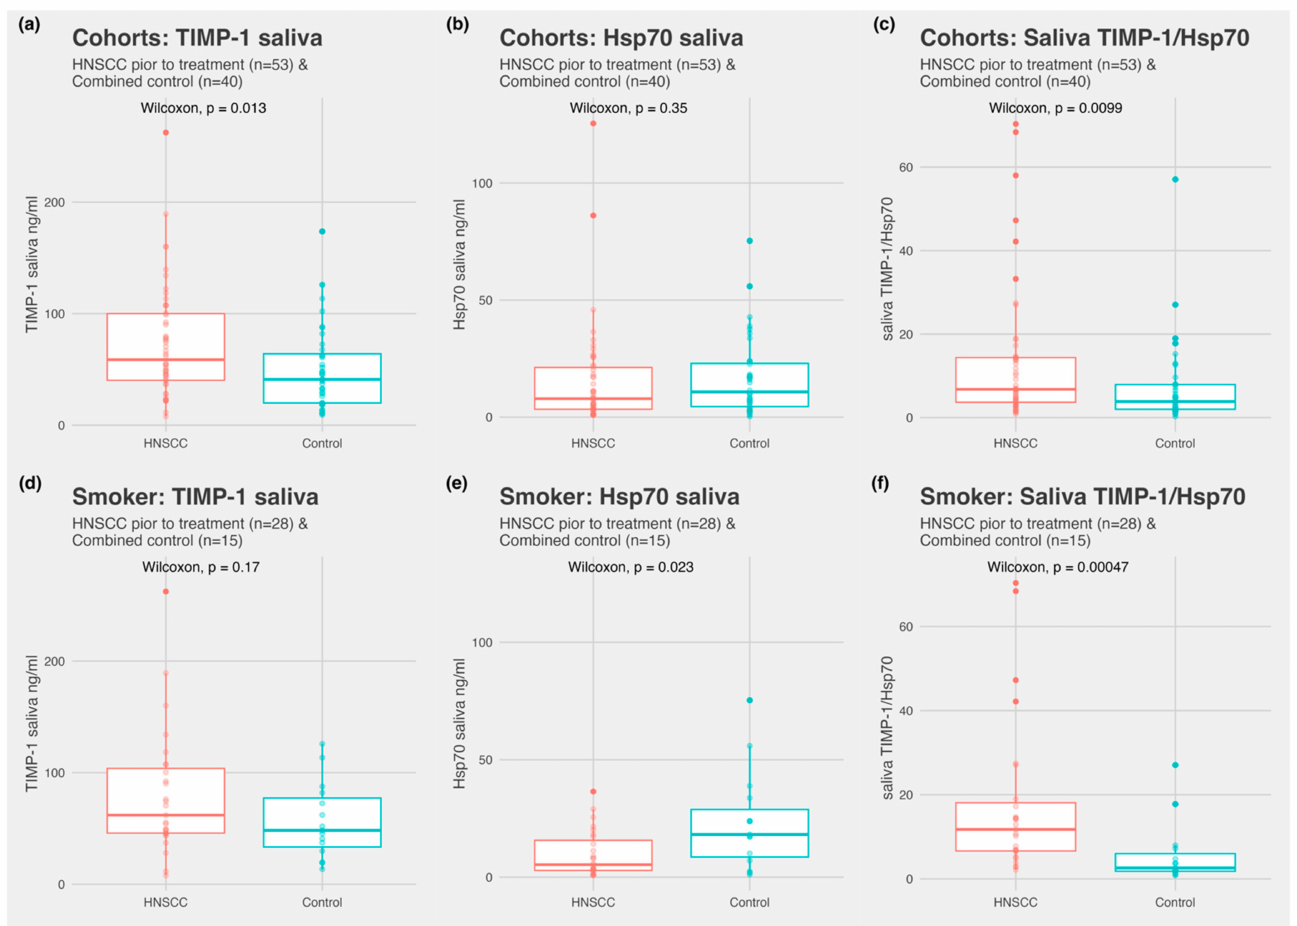
Figure 3. Comparing pretreatment HNSCC ( n = 53) and combined control subjects ( n = 40) for TIMP-1 and Hsp70 both in serum and saliva. ( a ) TIMP-1 saliva concentration in HNSCC and combined control subjects; ( b ) Hsp70 saliva concentration in HNSCC and combined control subjects; ( c ) TIMP- 1/Hsp70 saliva ratio comparing HNSCC and combined control subjects; ( d ) saliva TIMP-1 in smokers with HNSCC and combined smoking control subjects; ( e ) saliva Hsp70 in smokers with HNSCC and combined smoking control subjects; and ( f ) TIMP-1/Hsp70 ratio in smokers with HNSCC and combined smoking control